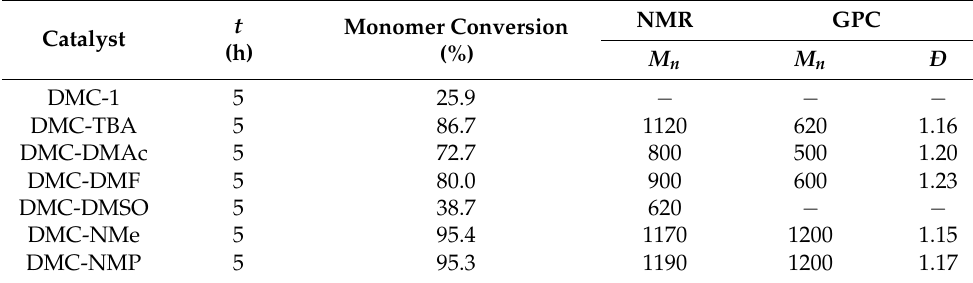
Table 4. Results of the ROP of CL using various DMC